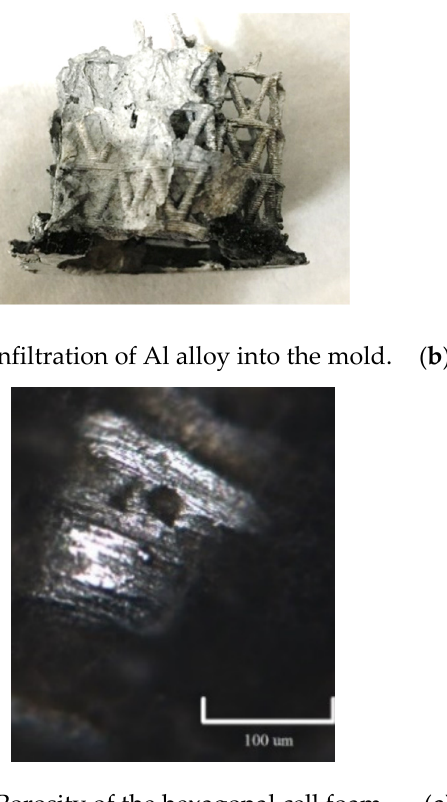
Figure 8. Main defects in Al alloy open foam. ( a ) Al infiltration; ( b ) cells not completed; ( c ) infiltration of Al in the vents; ( d , e ) porosity of hexagonal cell foam; ( f ) layer evidenced in truncated octahedron elementary cell Al alloy foam.